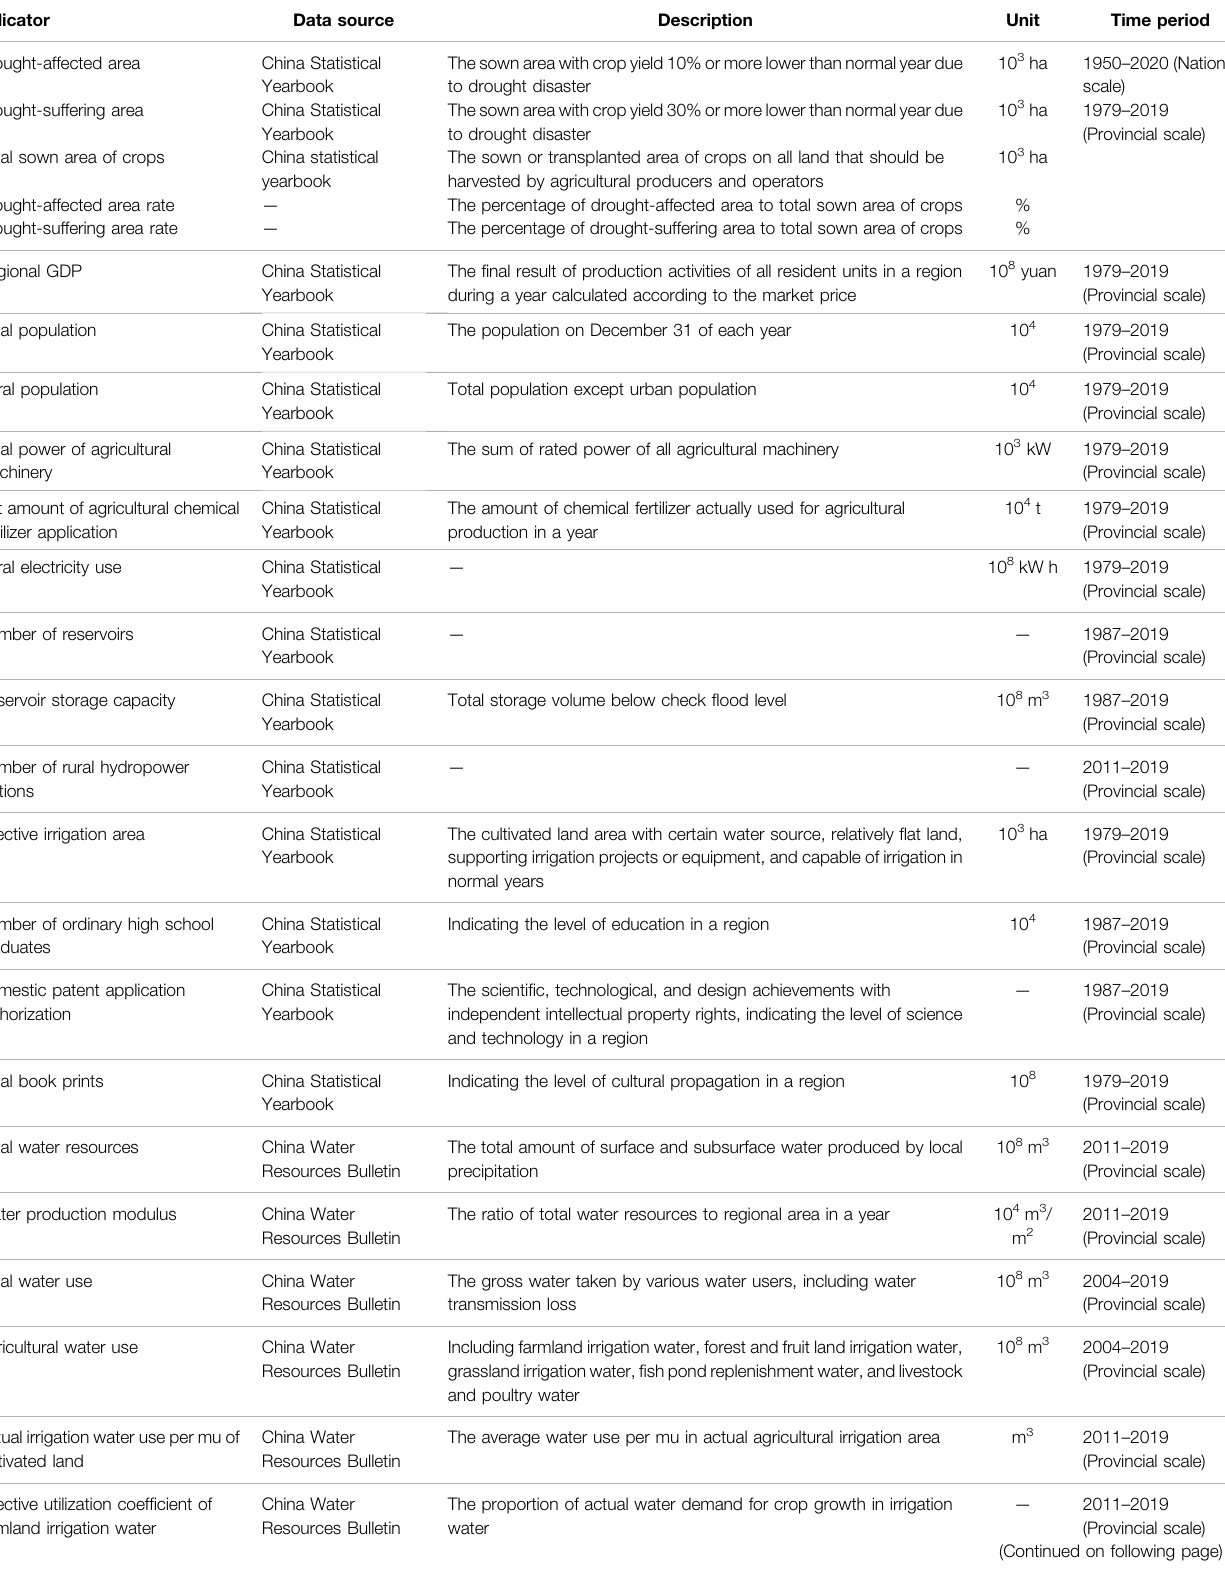
TABLE 1 | List of indicators; their data sources and brief description are provided